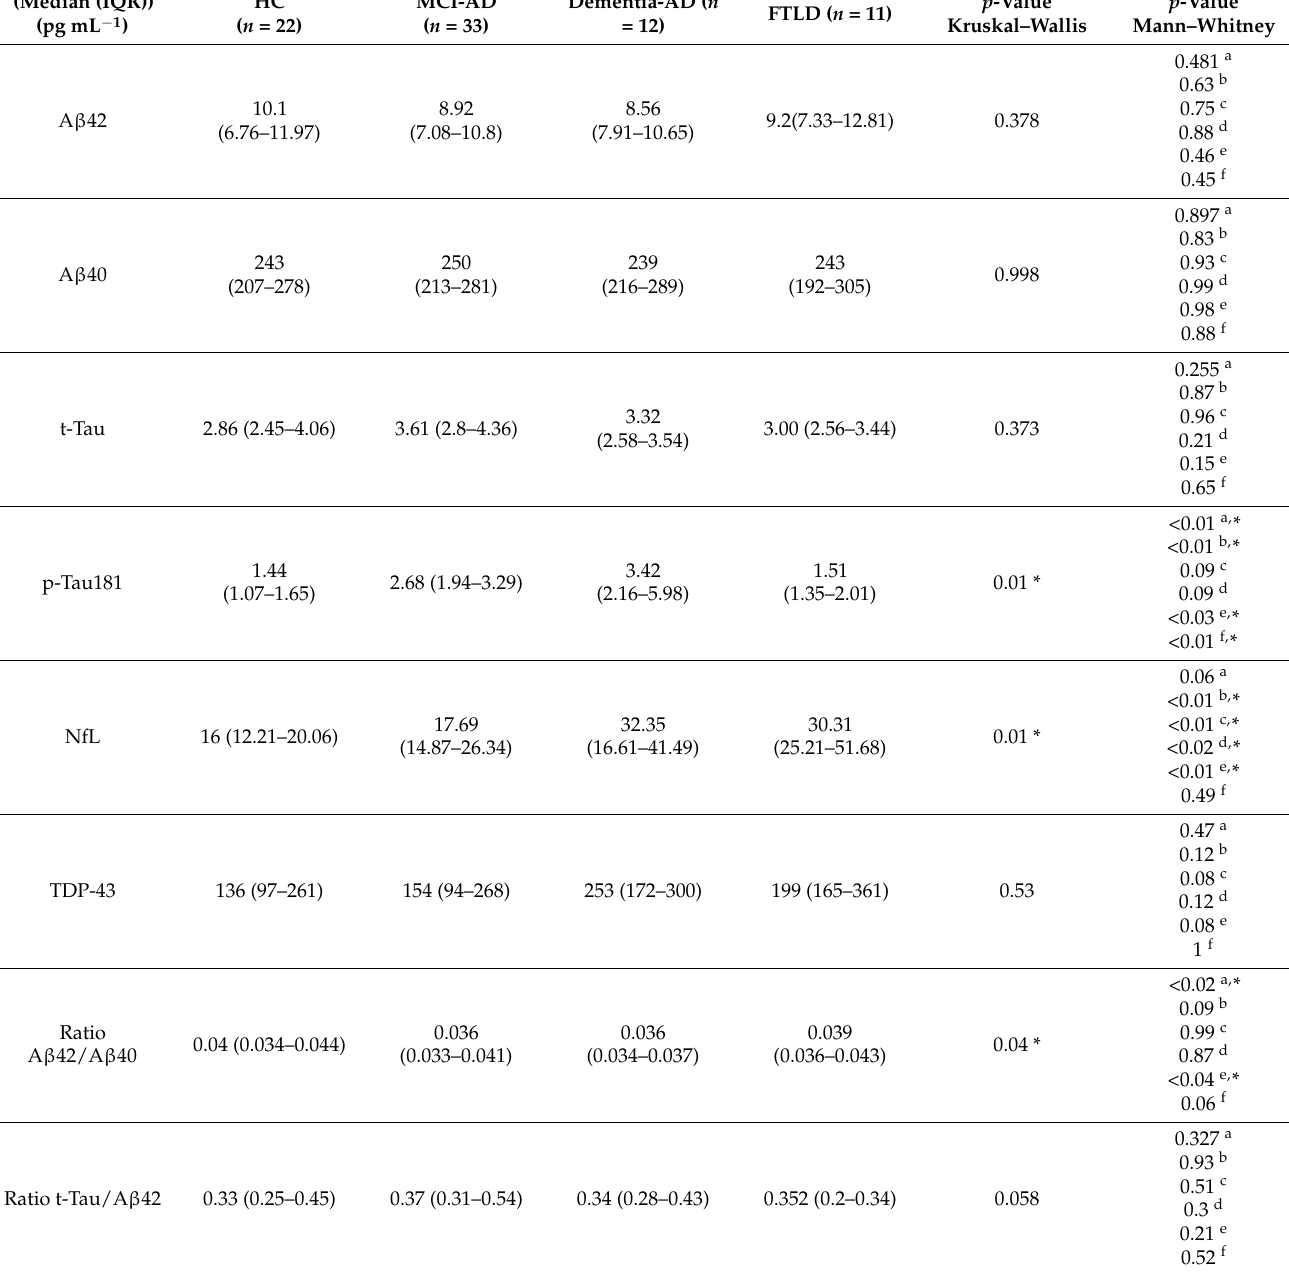
Table 3. Plasma biomarkers levels obtained for each participants